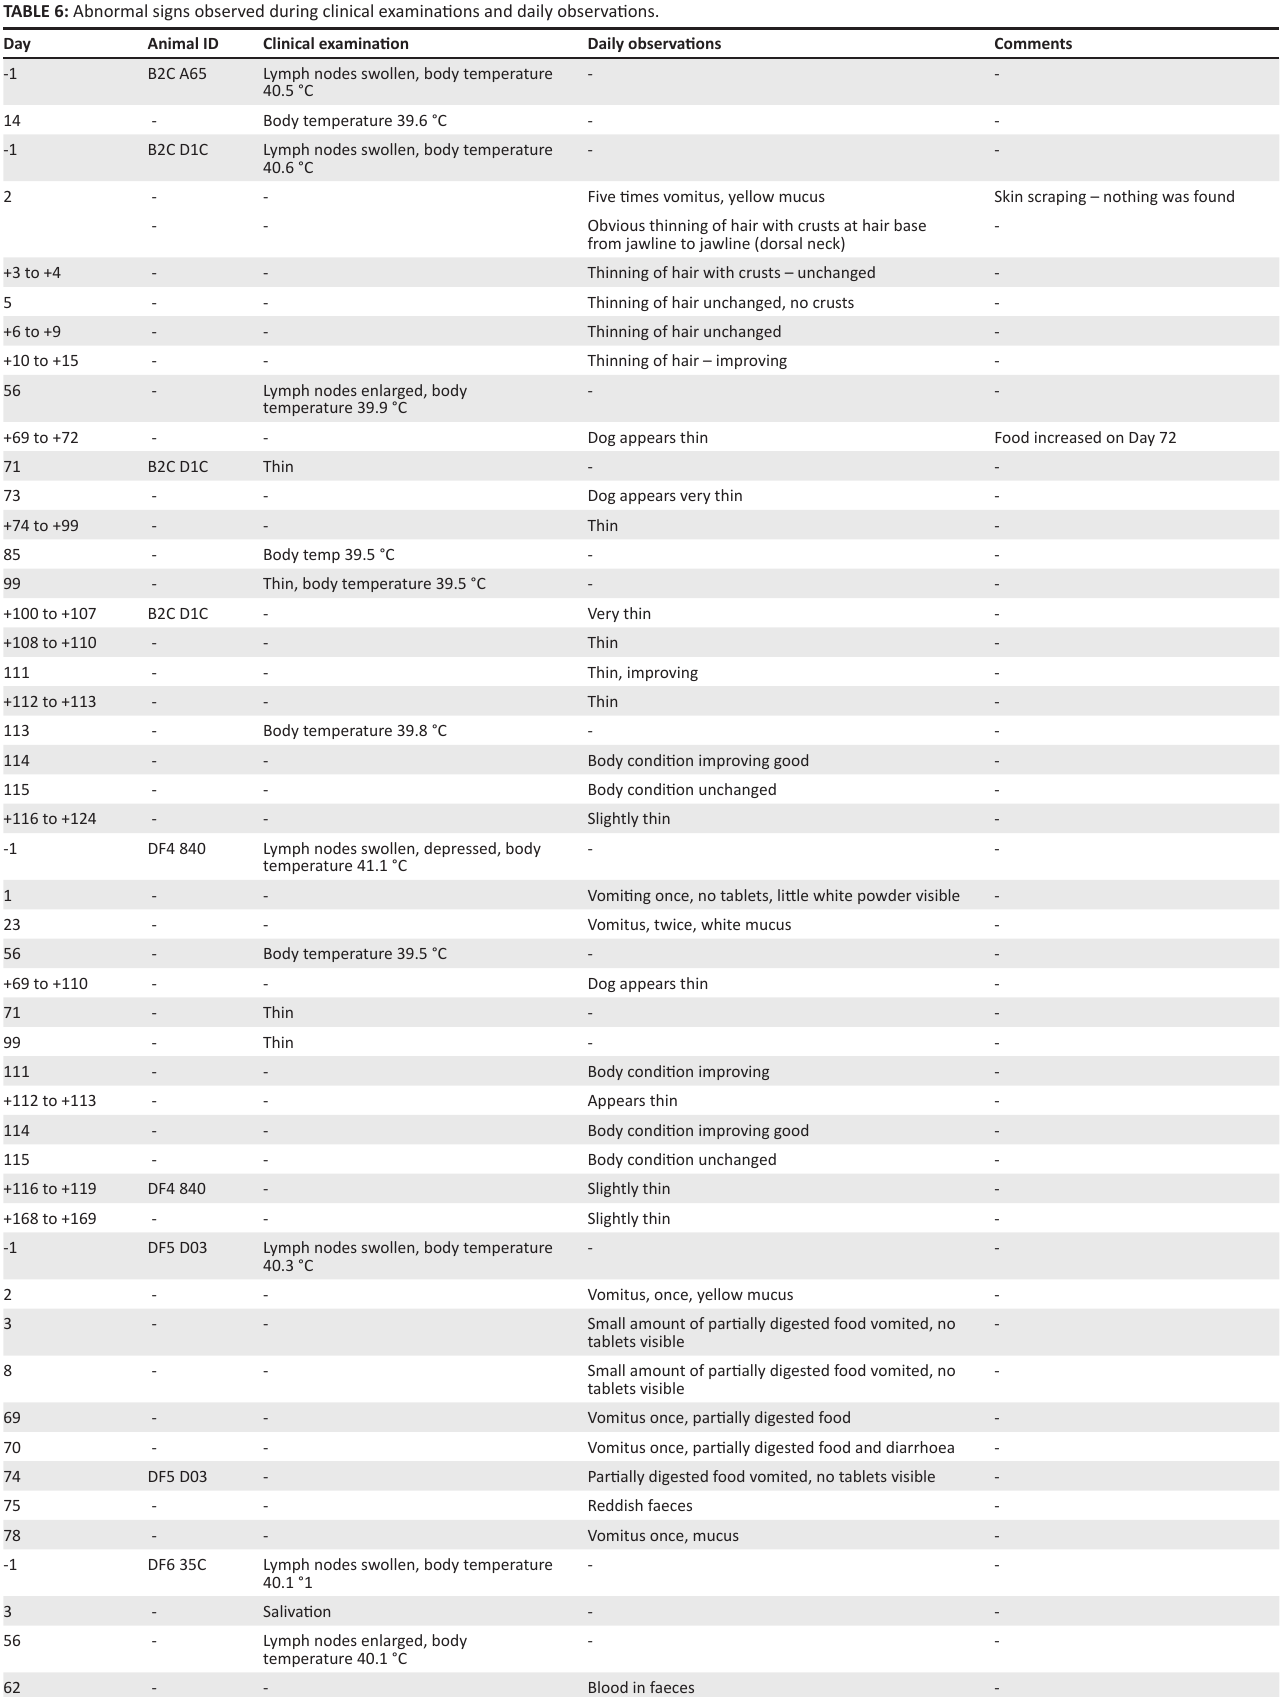
TABLE 6: Abnormal signs observed during clinical examinations and daily